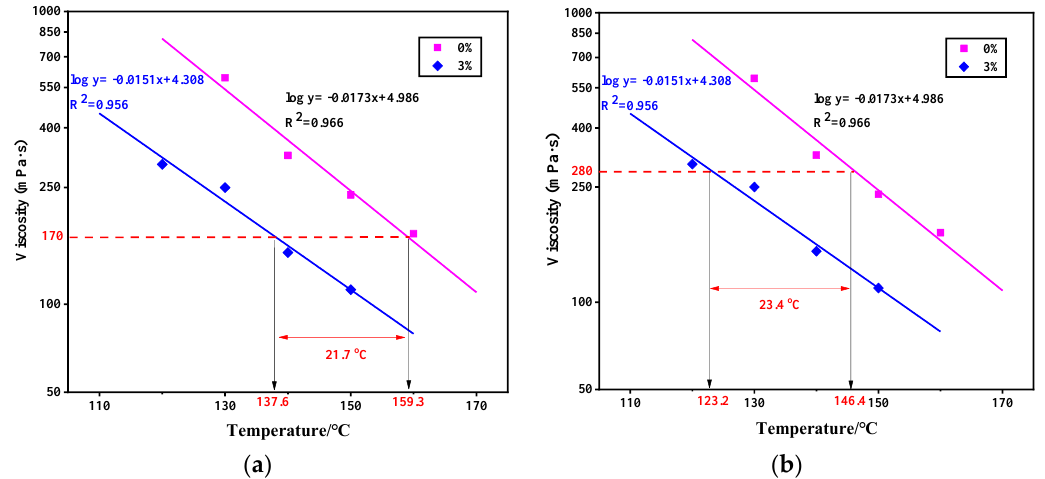
Figure 5. Viscosity versus temperature of the original and foamed asphalt binders: ( a ) Determination of mixing temperature; ( b ) determination of compaction temperature.